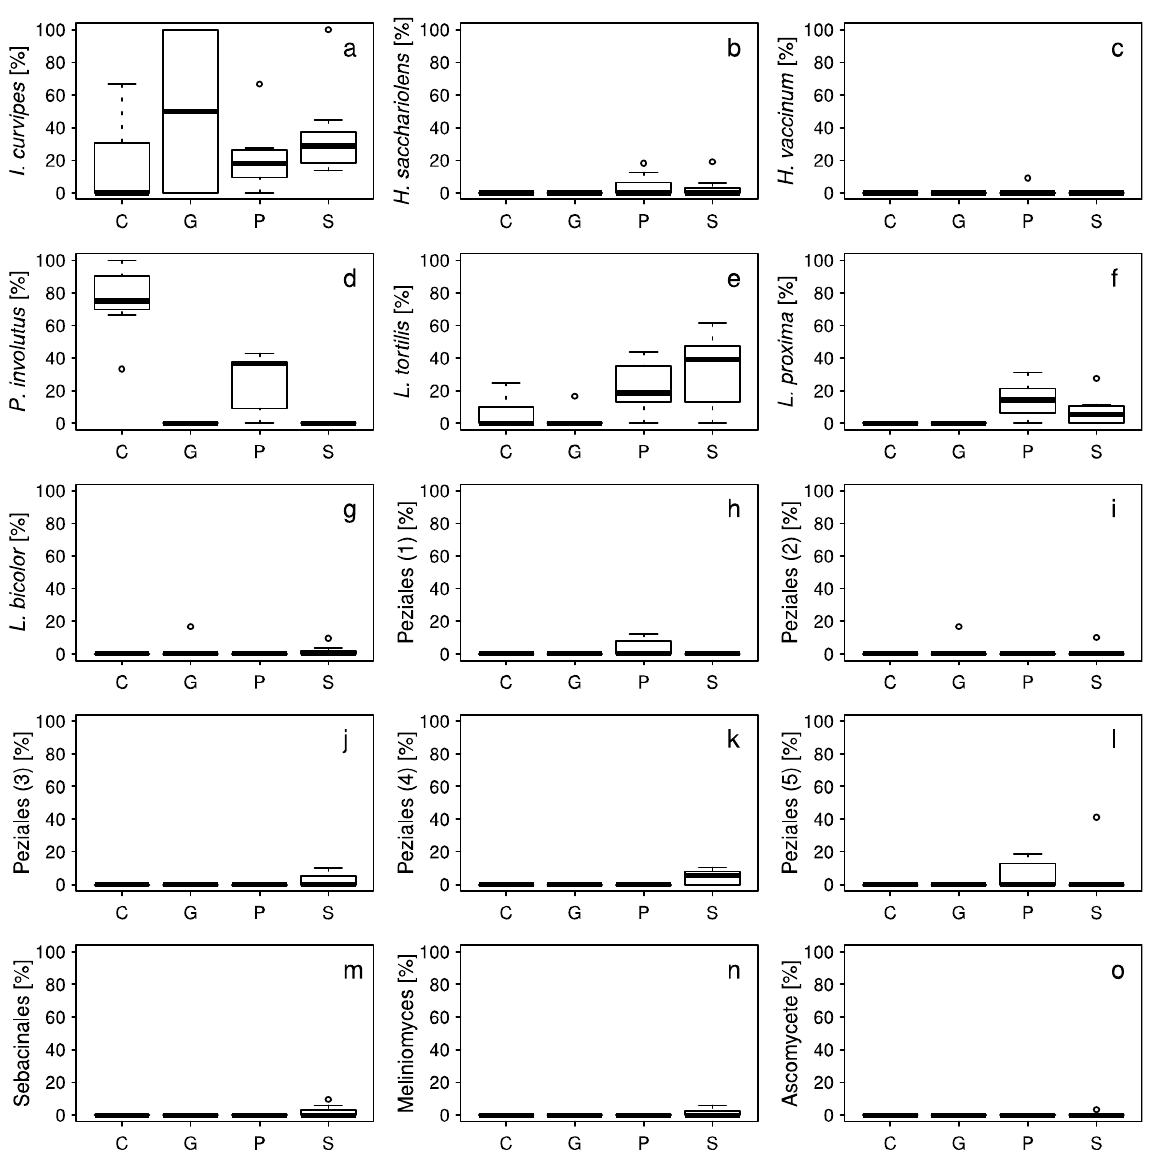
Figure 4. ECM diversity ((%) in 20 min sampling) in the four soils originating from different former land use types (C = cornfield, G = grassland, P = poplar soil, S = spruce